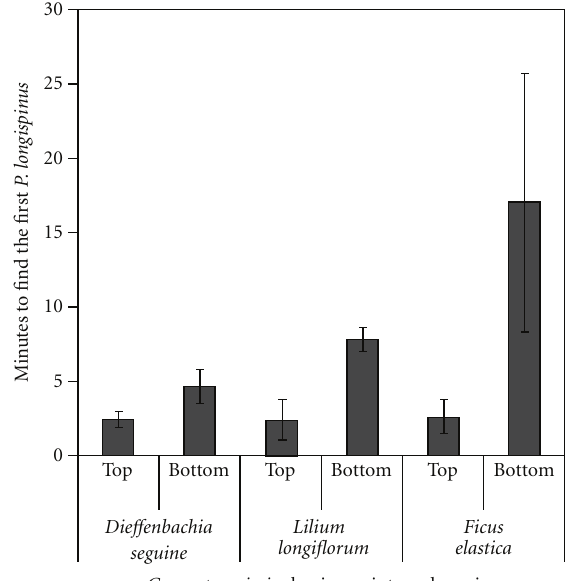
Figure 1: E ff ects of C. montrouzieri release locations and plant species on the time C. montrouzieri spent to find the first P.